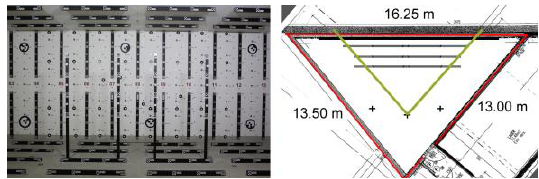
Fig. 5 a: Calibration structure (left) and floorplan with three camera positions (+) and FOV of the UltraCam Condor (green triangle).